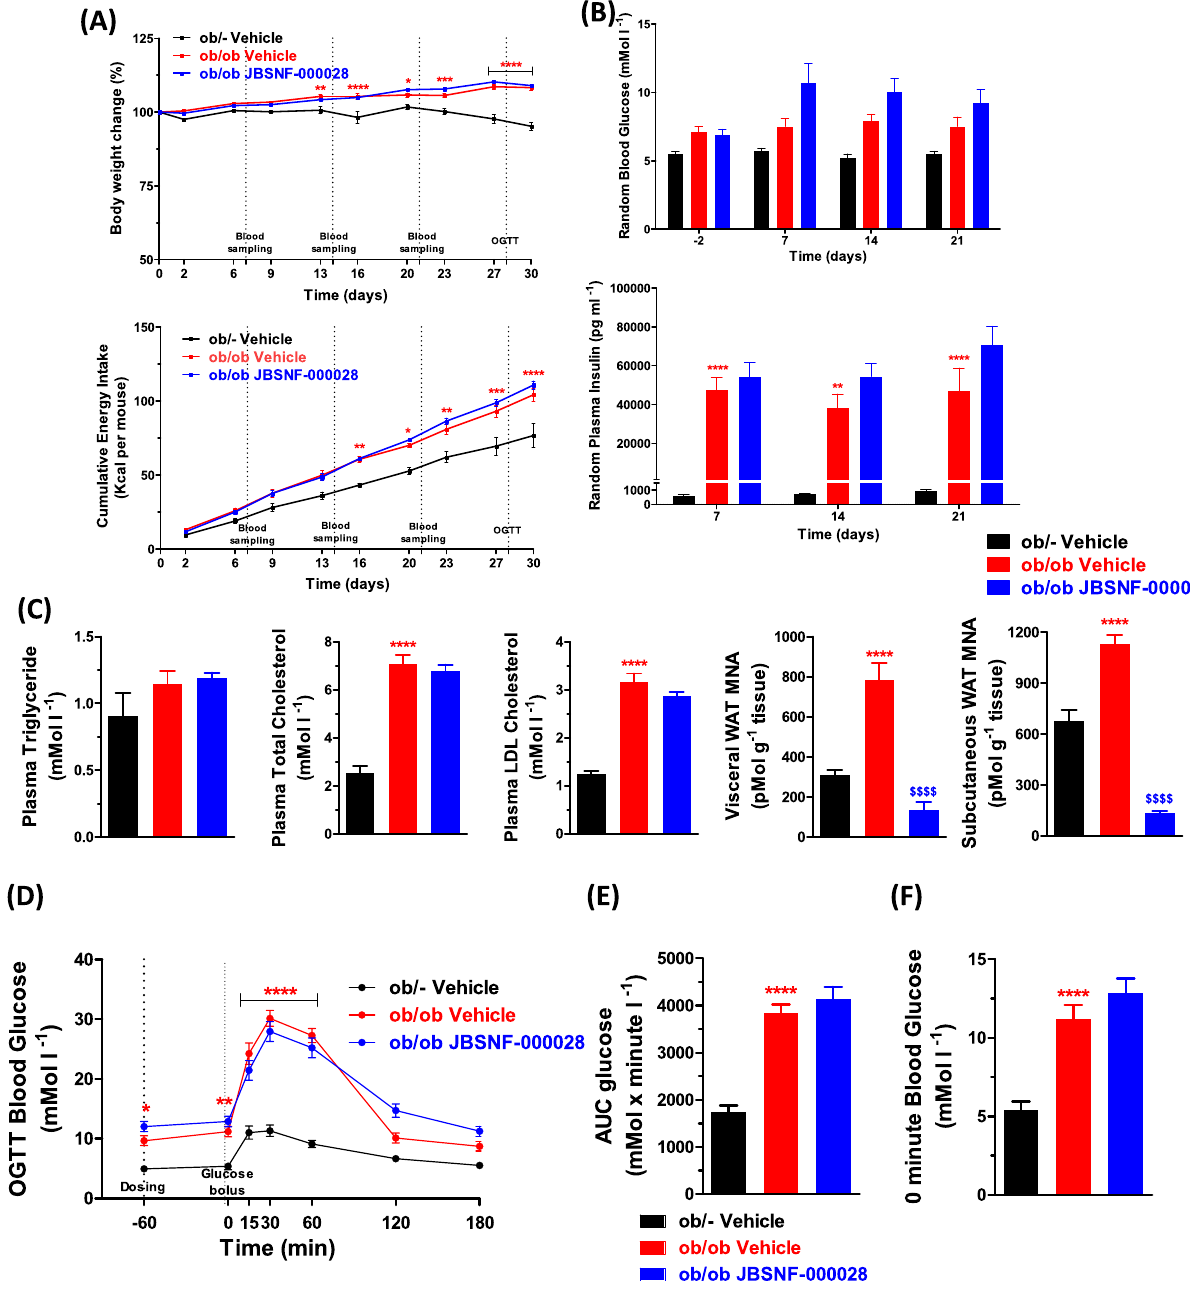
Figure 7. Efficacy of JBSNF-000028 in ob/ob model. ( A ) Body weight changes (%) and cumulative energy intake in ob/– control animals and ob/ob animals treated with vehicle or JBSNF-000028 at 50 mg kg −1 . ( B ) Fed blood glucose and fed plasma insulin profile of ob/– control animals and ob/ob animals treated with vehicle or JBSNF-000028 at 50 mg kg −1 . ( C ) Plasma triglycerides, plasma total cholesterol, plasma LDL cholesterol, MNA measurements in visceral WAT and s/c fat samples of ob/– control animals and ob/ob animals treated with vehicle or JBSNF-000028 at 50 mg kg −1 . ( D ) OGTT profile, ( E ) Area under the curve (AUC), ( F ) plasma glucose levels at the time of the glucose bolus. Data are presented as mean ± s.e.m. * p < 0.05, ** p < 0.01, *** p < 0.001 and **** p < 0.0001 when compared with ob/– control and $$$$ p < 0.0001 when compared with ob/ob vehicle control. Two way ANOVA followed by Bonferroni’s post-hoc test ( A , B , D ); One way ANOVA followed by Bonferroni’s post-hoc test ( C , E , F